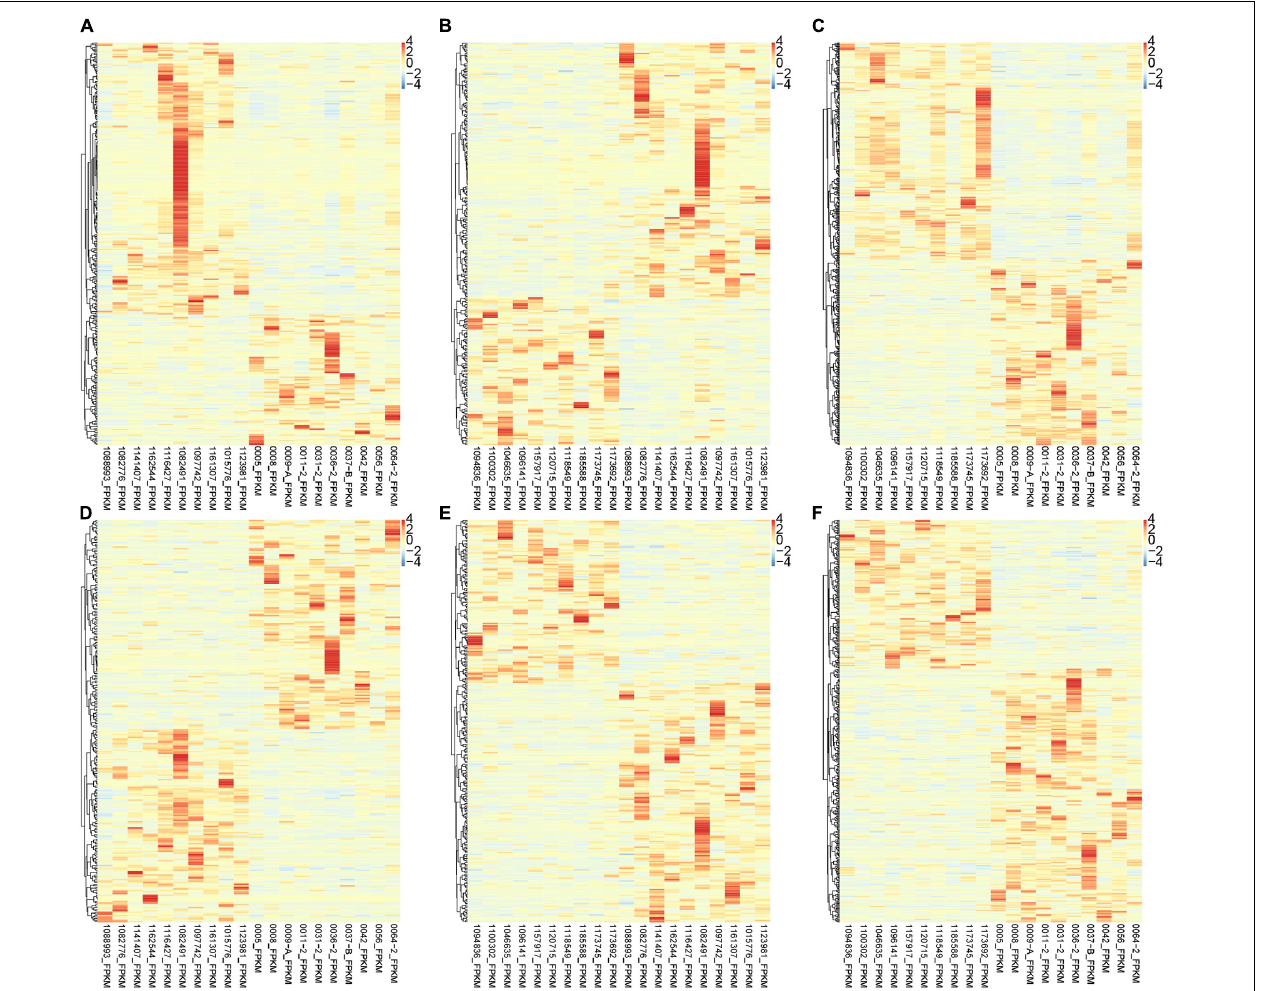
FIGURE 2 | Identification of DEmRNAs and lncRNAs among normal, paroxysmal AF and persistent AF samples. (A–C) The heat map shows the DEmRNAs in paroxysmal AF compared to normal samples (A) , persistent AF compared to normal samples (B) , and persistent AF compared to paroxysmal AF samples (C) . (D–F) The heat map shows the differently expressed lncRNAs in paroxysmal AF compared to normal samples (A) , persistent AF compared to normal samples (B) , and persistent AF compared to paroxysmal AF samples (C)